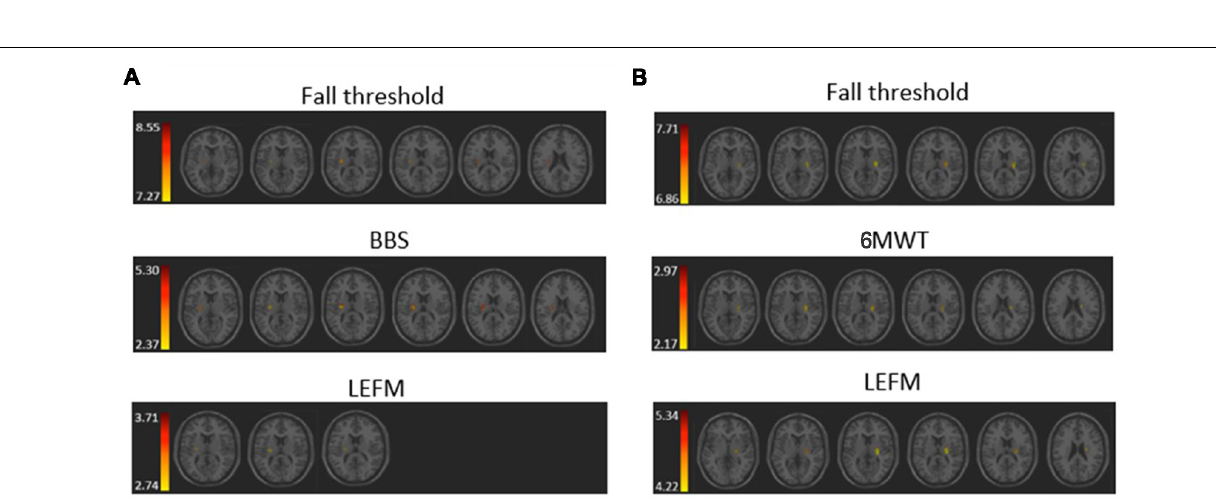
FIGURE 2 | Lesion overlay maps of right hemisphere damaged (RHD, n = 24) and left hemisphere damaged (LHD, n = 22) groups—top and bottom rows, respectively. Representative normalized slices (out of 90 normalized slices employed) are displayed in radiological convention (right hemisphere on left side and vice versa), with warmer colors indicating greater lesion overlap (units: number of patients with lesion in the colored region).